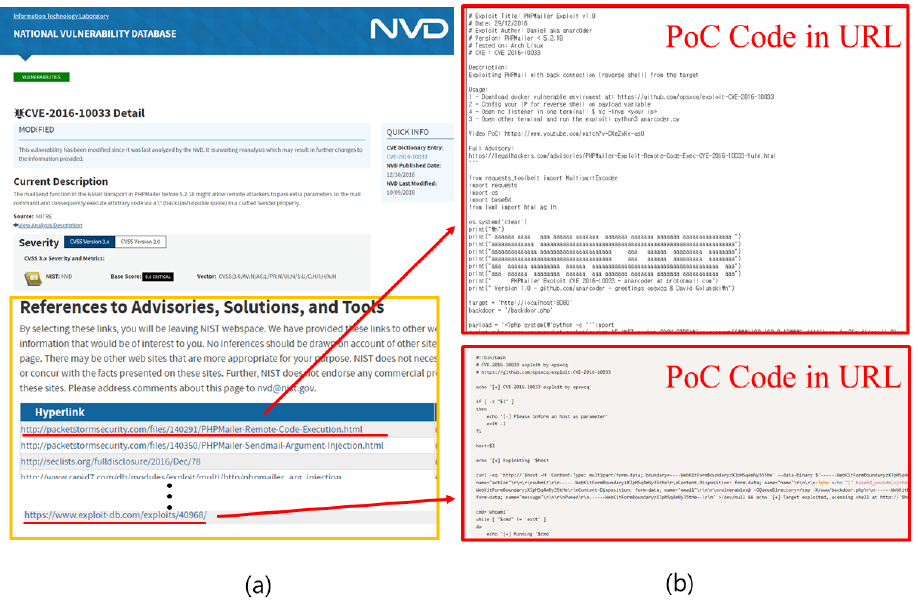
Figure 3. Example of vulnerability information in NVD; ( a ) CVE-2016-10033 vulnerability information in NVD, ( b ) Example of PoC Code in Reference URL